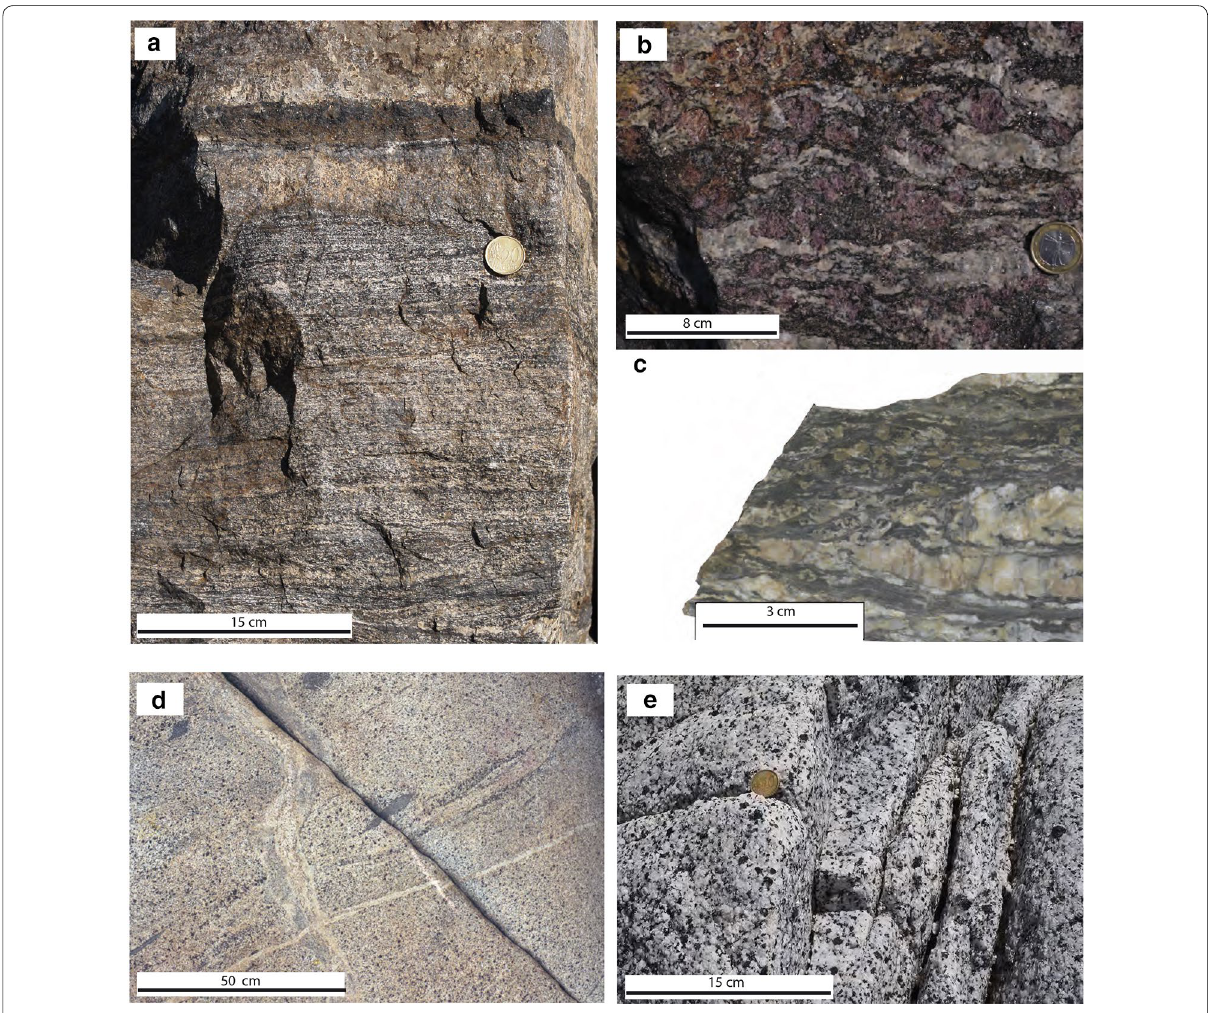
Fig. 7 Calabria lower ( a – c ) and intermediate crust ( d , e ): a granulitic metagabbro (Curinga); b felsic granulite, garnet-sillimanite rich fels (Marina di Vibo); c Bt Pl Kfs Sil Grt Ms bearing migmatitic paragneiss (kinzigite Auct.); d tonalite emplaced at middle crust level and characterized by + + + + ± a dominant magmatic fabric (Ioppolo); e foliated peraluminous granodiorite